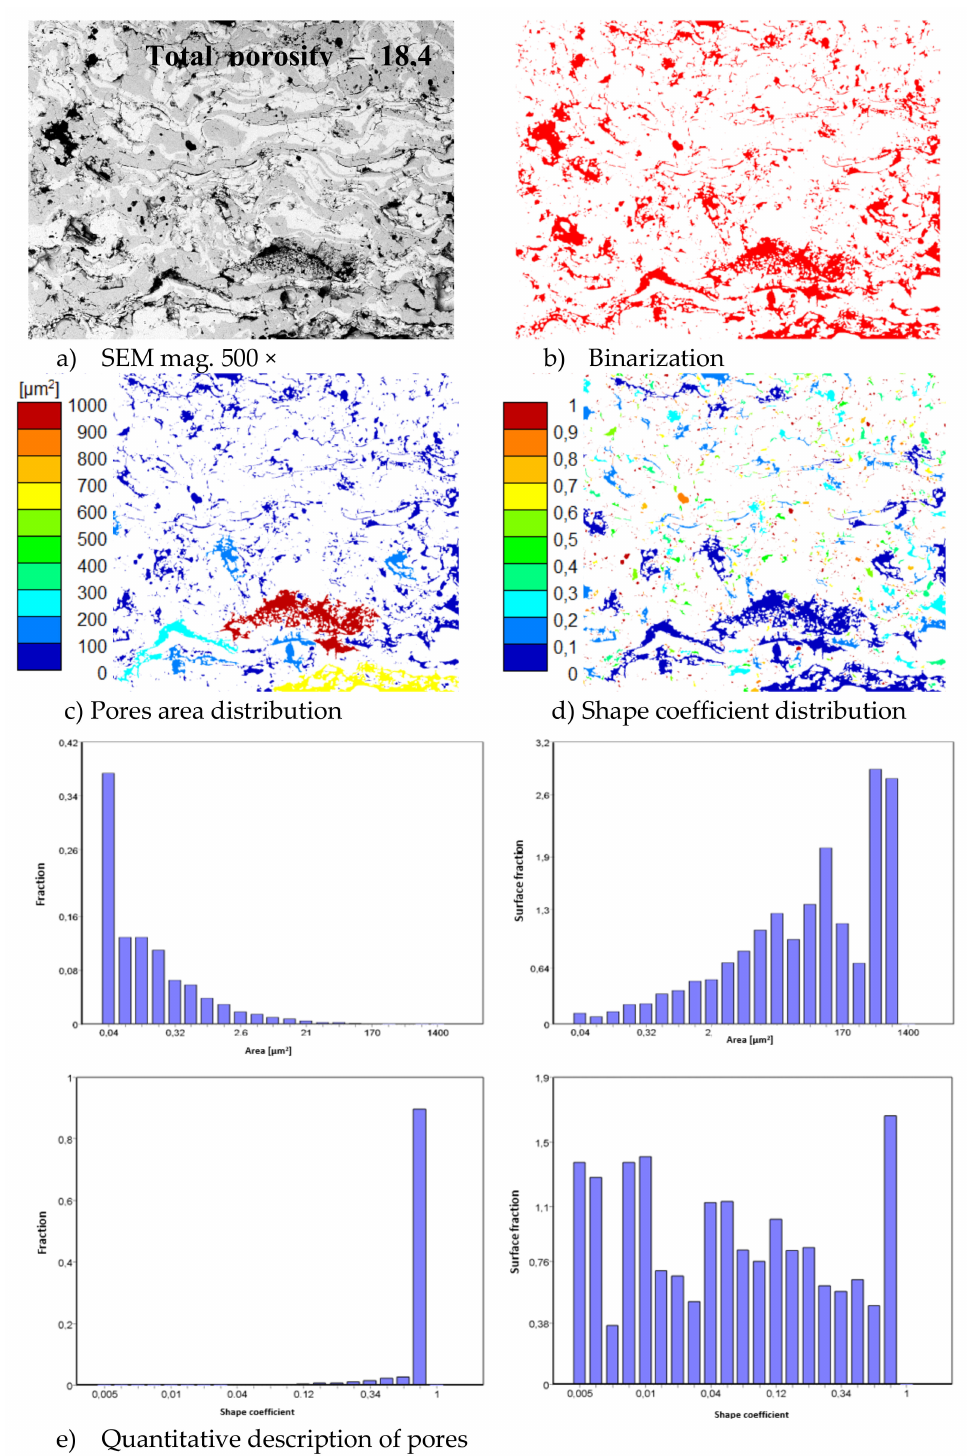
Figure 7. The image analysis results describe pores and voids morphology from quantitative and qualitative points of view for the composite 50% La 2 Zr 2 O 7 + 50% 8YSZ system: ( a ) SEM image, ( b ) binarization of pores and cracks, ( c ) visual evaluation of pores area distribution, ( d ) visual evaluation of pores shape coe ffi cient distribution, ( e ) quantitative evaluation of pores area and shape coe ffi cient